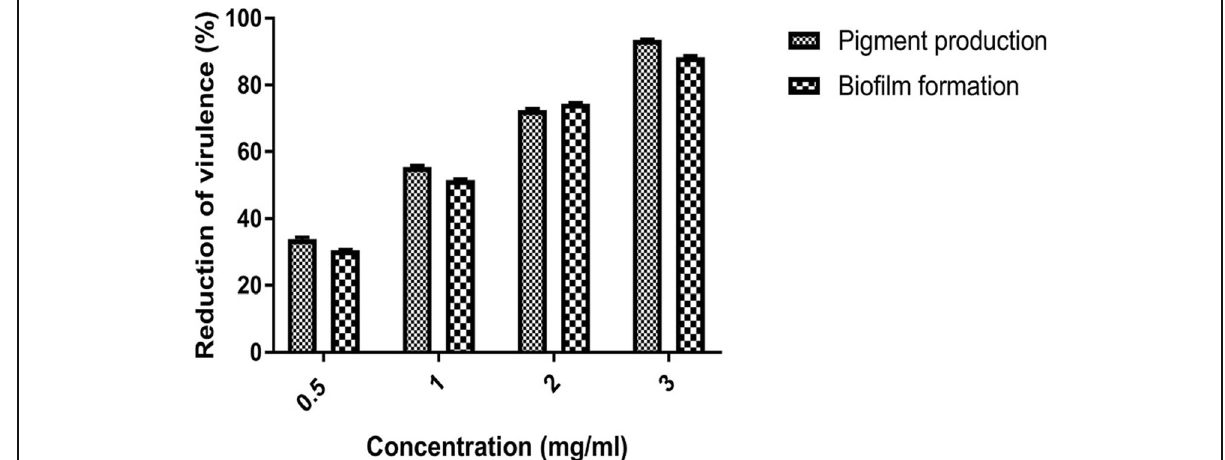
Fig. 1 Effect of STRE upon quorum sensing dependent functions pigment production and biofilm